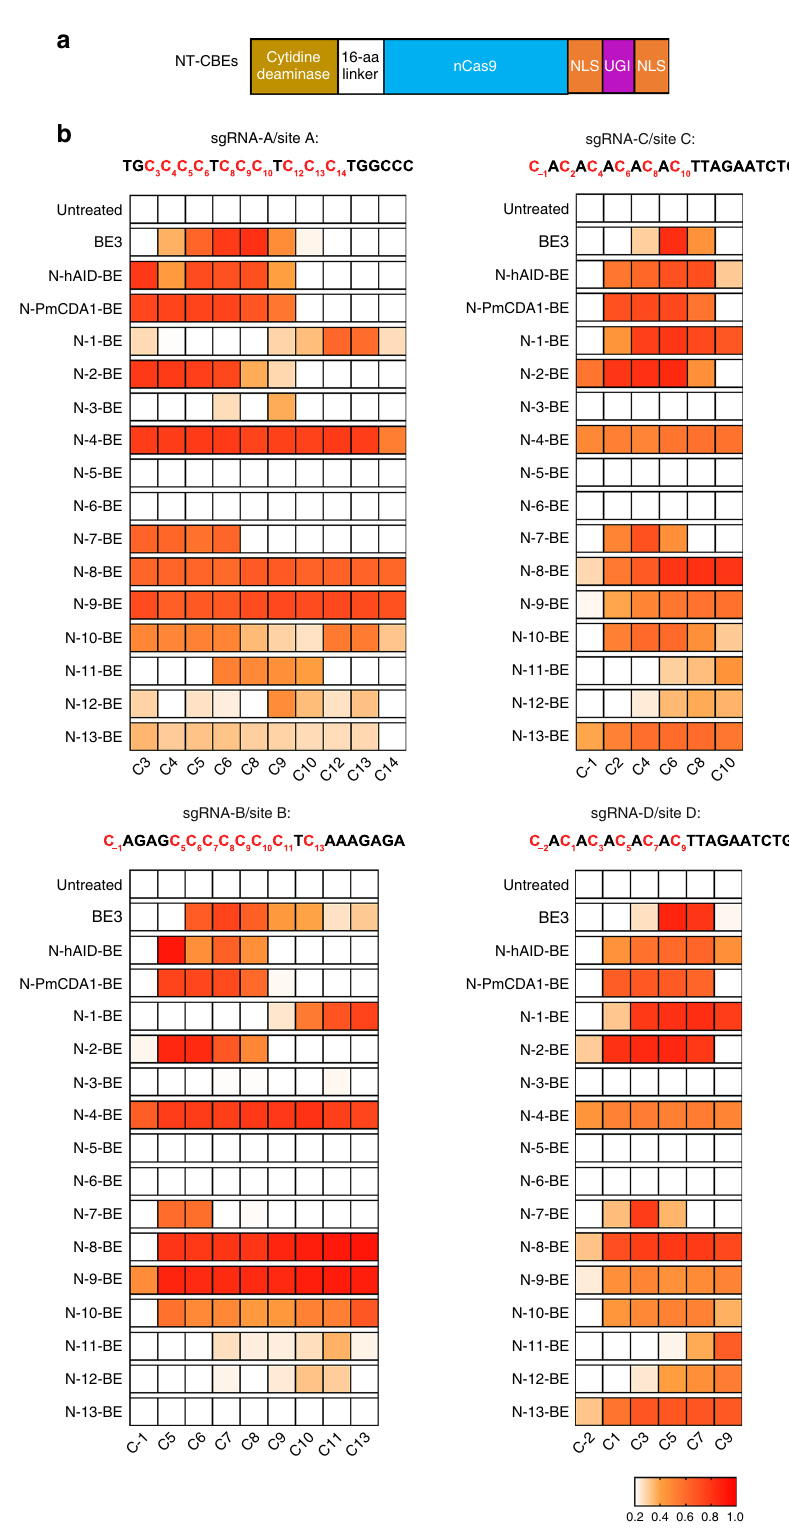
Fig. 2 Overview of base editing activities of NT-CBEs. a Organization of NT-CBEs. NT-CBEs were generated by fusing different cytidine deaminases to the N-terminus of nCas9. b Base editing activities of NT-CBEs against four sgRNAs. sgRNA-A/B/C/D were used and C – T conversion frequencies at every cytosine located in regions 30bp upstream of PAM sites were calculated and heat map showing the editing ef fi ciencies for the critical C sites. Several C sites were not shown because of their low editing ef fi ciencies for all NT-CBEs tested in this study. Data here are represented as mean for three independent experiments. Source data are provided as a Source Data fi